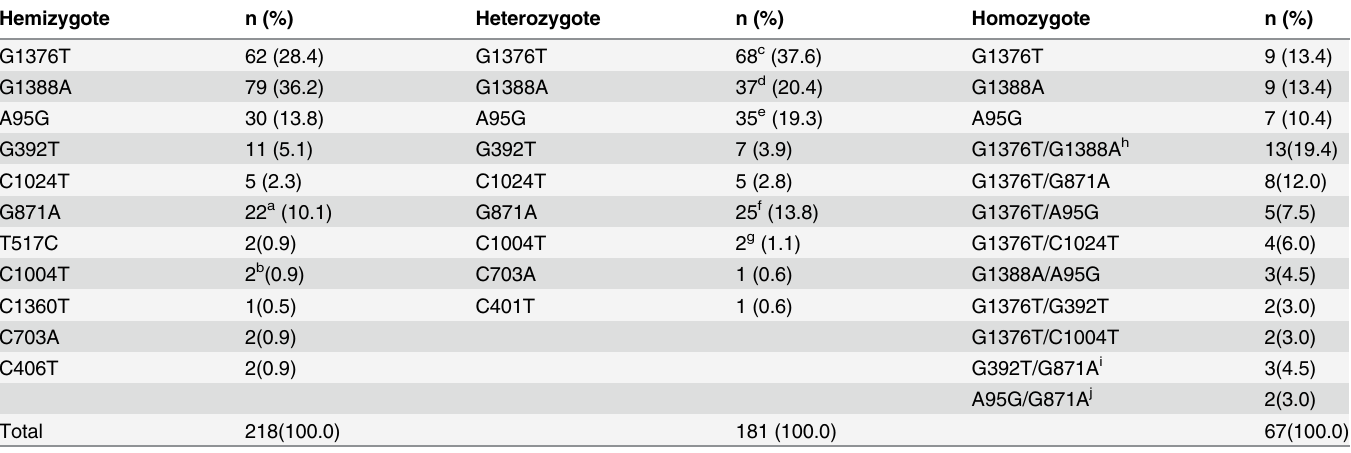
Table 3. Thirty-two different genotypes associated with G6PD de fi ciency and their contributions in Dongguan. Hemizygote